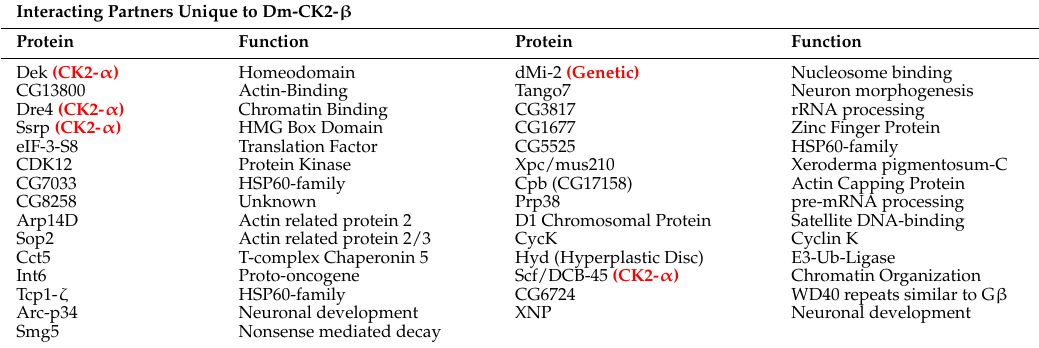
Table 4. Dm-CK2- β and Dm-CK2- β (cid:48) interactors in Drosophila S2-cells